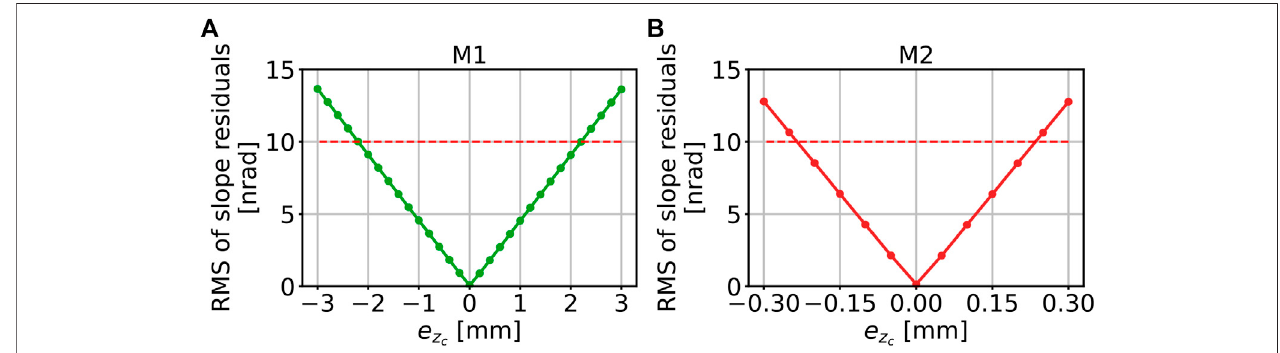
FIGURE 9 | The e z tolerance values versus the curvature variation ranges of the ellipses of q -series, θ -series, L -series, M1, and M2. The tolerance of the e z c generally gets tighter when a mirror with a larger curvature range is under test.